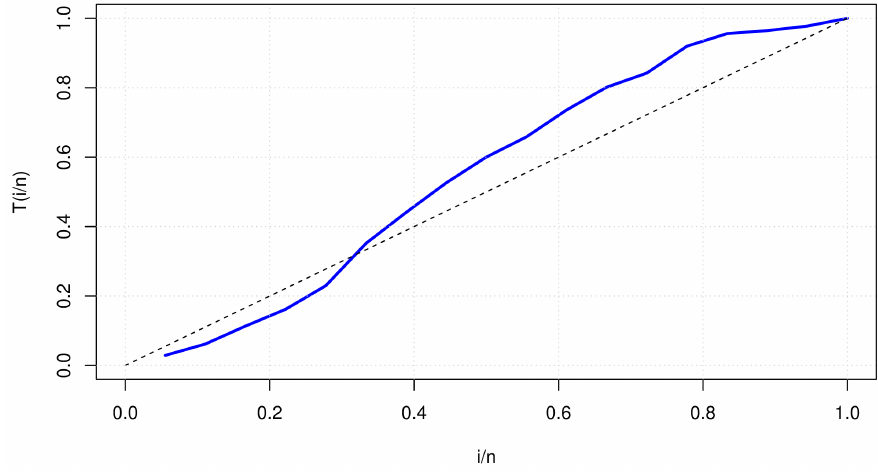
Figure 7. TTT plot for Data presented in Table